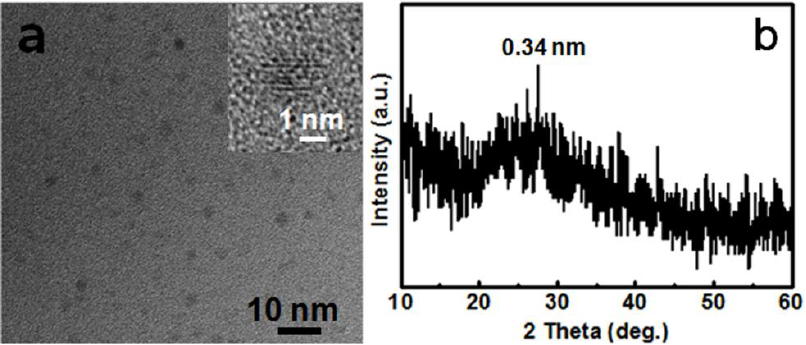
Figure 2. ( a ) TEM image and ( b ) XRD pattern of the CQDs-120.